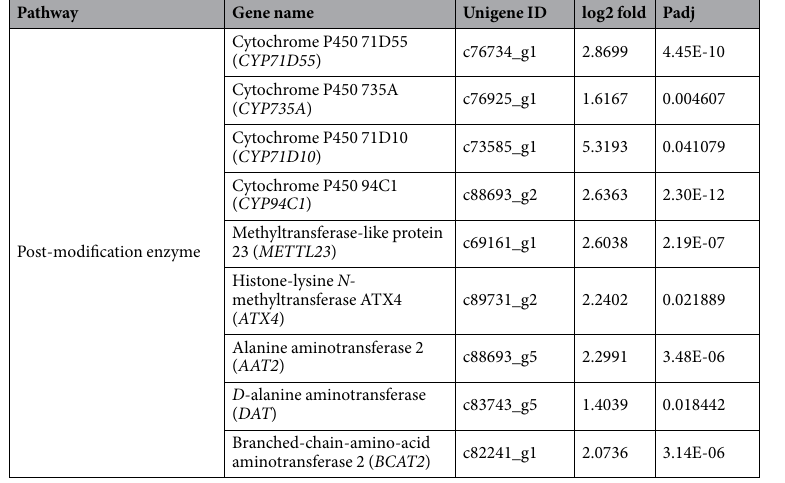
Table 2. DEGs involved in post-modification